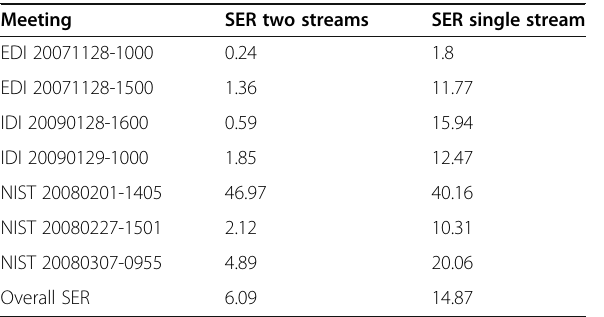
Table 11 Results meeting by meeting comparing the system that uses TDOAS versus the system that does not use it Meeting SER two streams